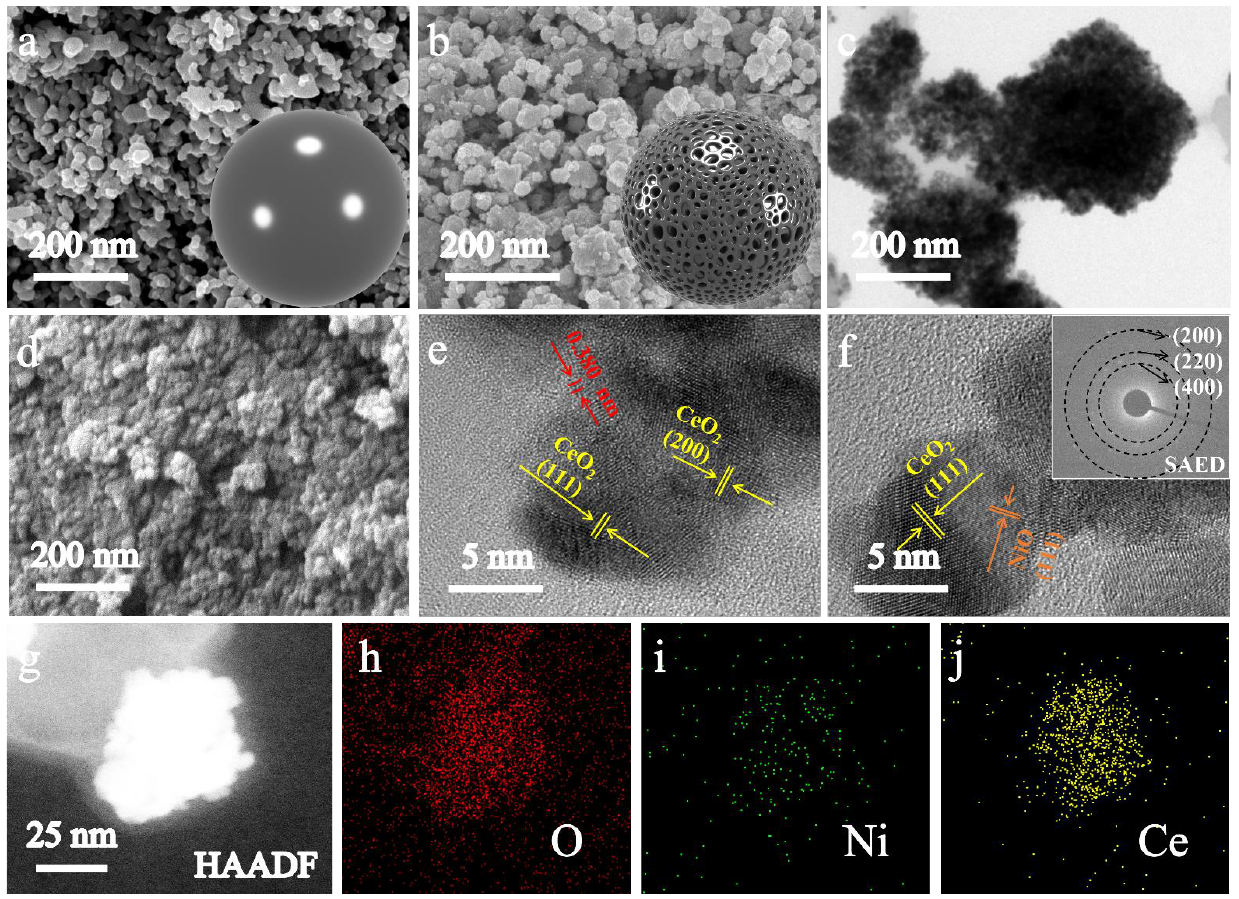
Figure 3. SEM images of FS ( a ), AFS ( b ), and 0.4(0.4NiO − CeO 2 ) − AFS ( d ). TEM images of AFS ( c ). HRTEM images of 0.4(0.4NiO − CeO 2 ) − AFS ( e , f ). Elemental color mapping ( g − j ) of 0.4(0.4NiO − CeO 2 ) −